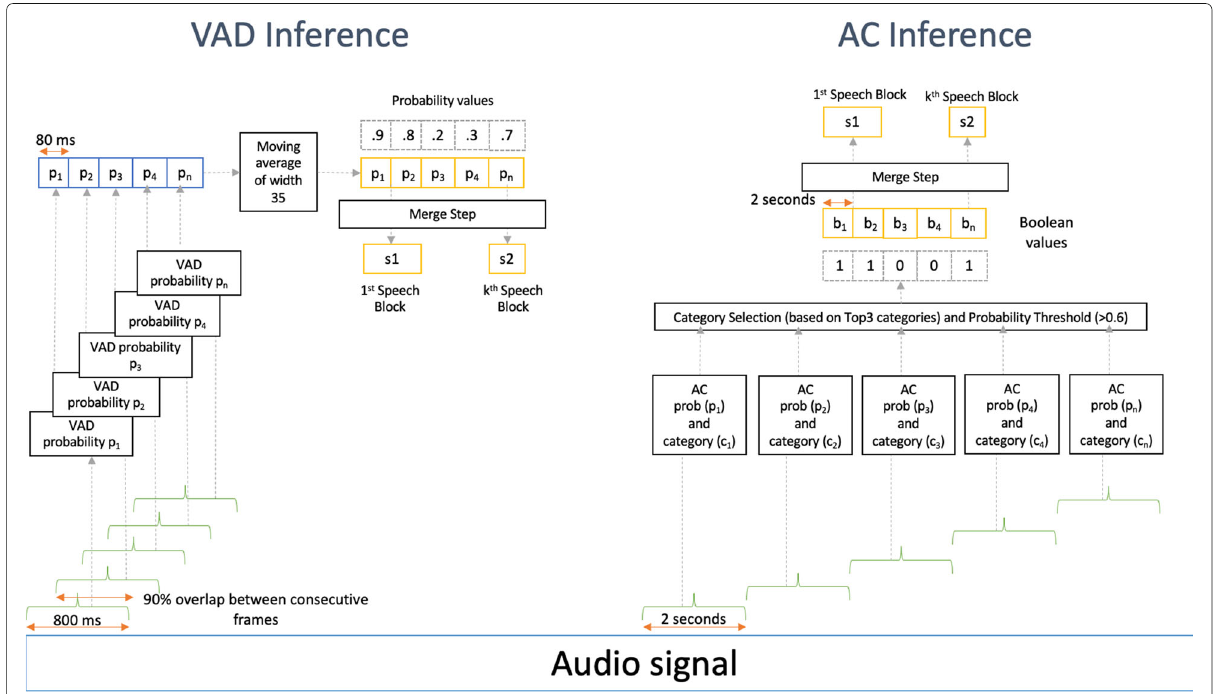
Fig. 5 Predicted subtitle block generation steps from VAD and AC models